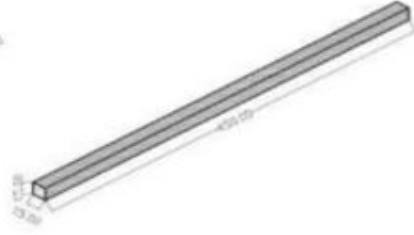
Figure 31. Dimensions of the Bending specimen (Author’s own, n.d.)